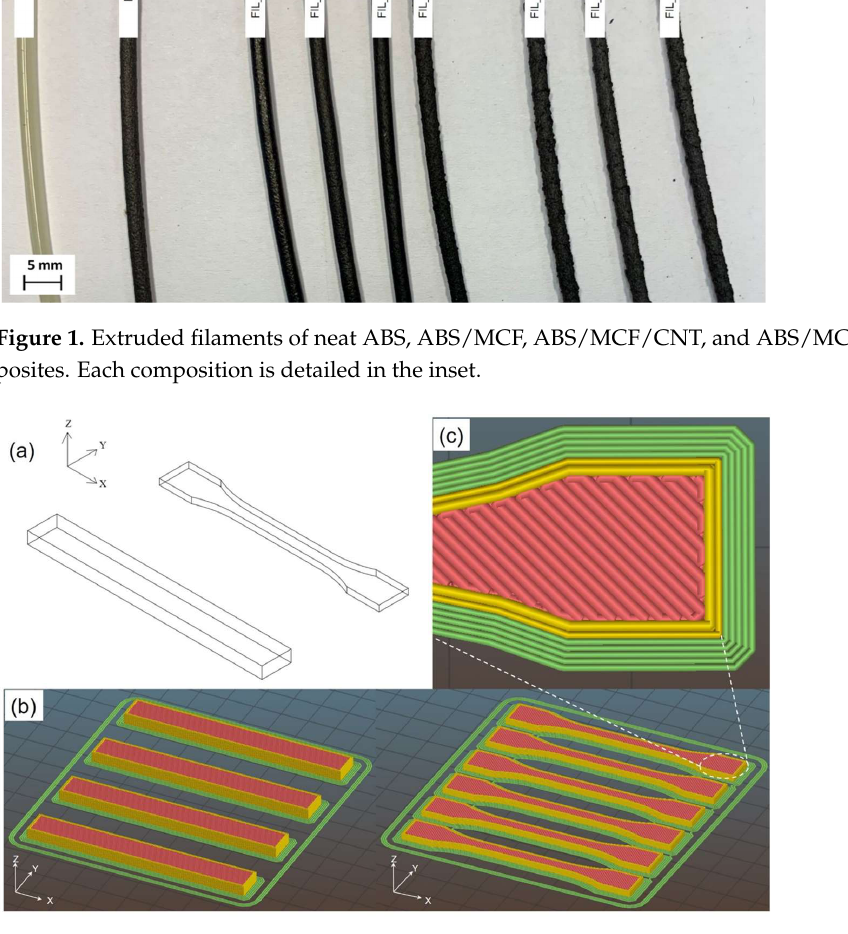
Figure 2. Schematic of the 1BA dumbbell and parallelepiped specimen (80 mm × 10 mm × 3.8 mm) ( a ), the arrangement of 3D-printed samples in Sil3r software ( b ), and detail of infill pattern ( c ).